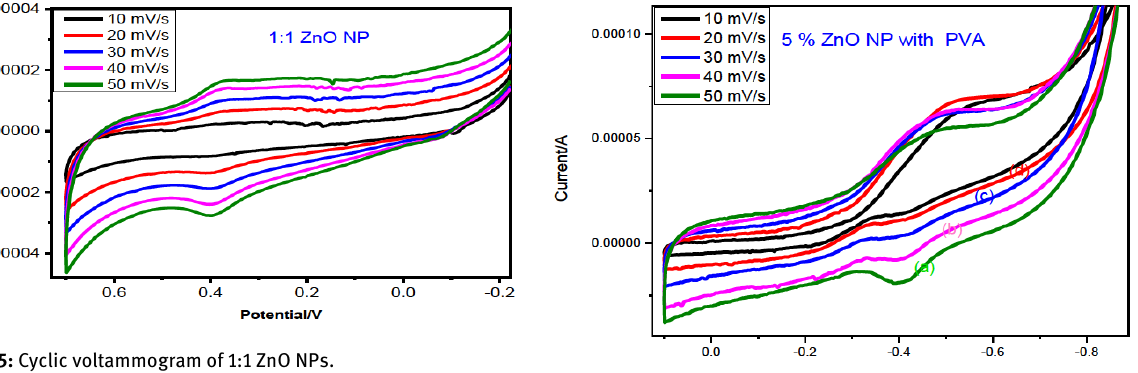
Figure 16: Cyclic voltammogram of 5%ZnO/PVA NC.